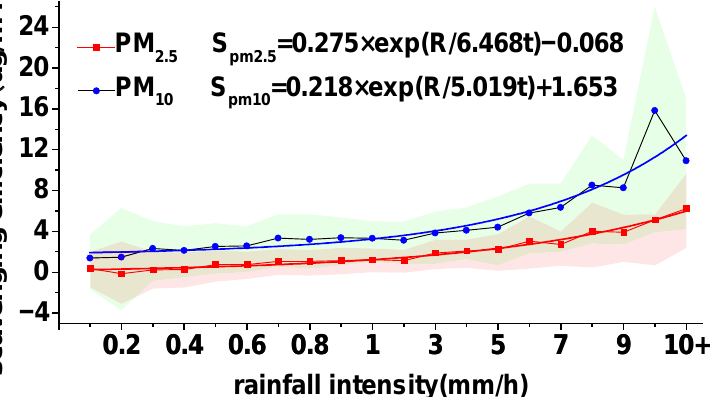
Figure 2. Relationship between precipitation intensity and scavenging efficiency ( SE ) (the dashed lines are the fitted curves, the green area is the interquartile span of PM 10 , the red area is the interquartile span of PM 2.5 , and the gray area is the overlapping region).